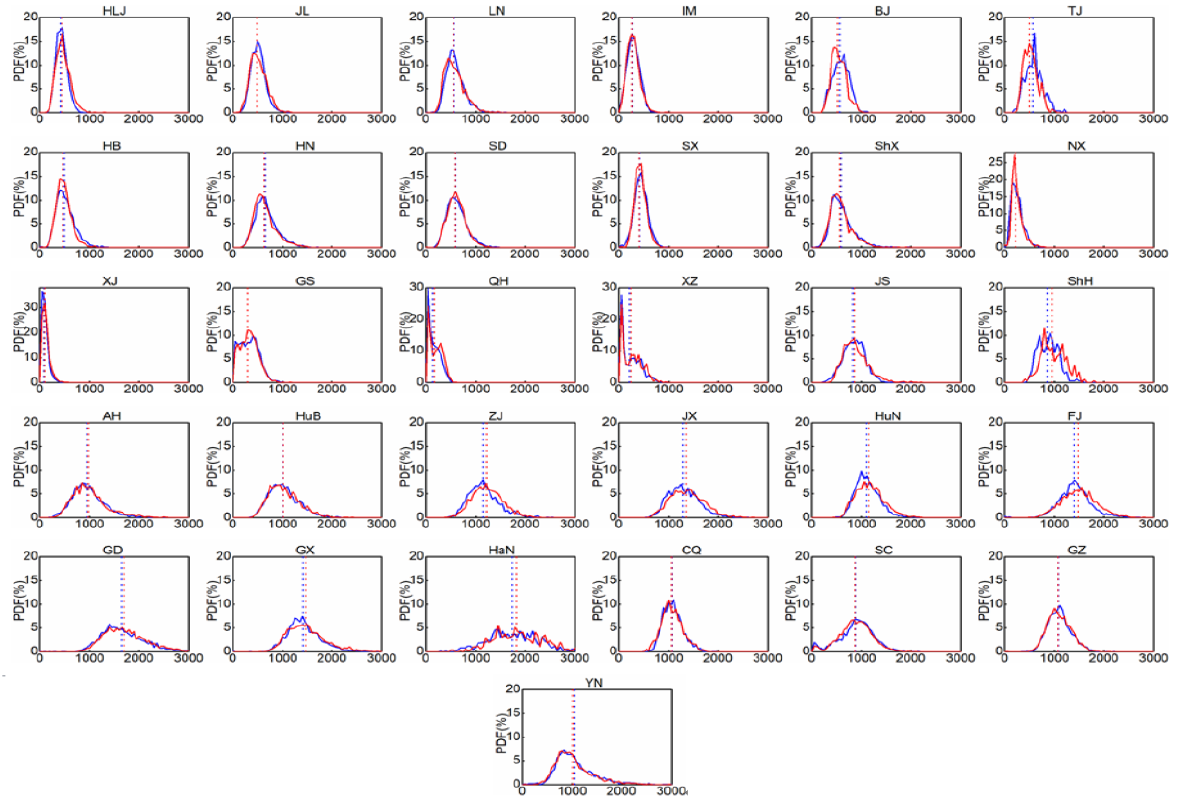
Figure 5. Probability density function patterns of precipitation during the potential agricultural growing season in 1961–1990 and 1991–2020 (blue and red curve represents the PDF value in 1961–1990 and 1991–2020, respectively; blue dotted line and red dotted line represents the mean magnitude of precipitation in 1991 – 2020).